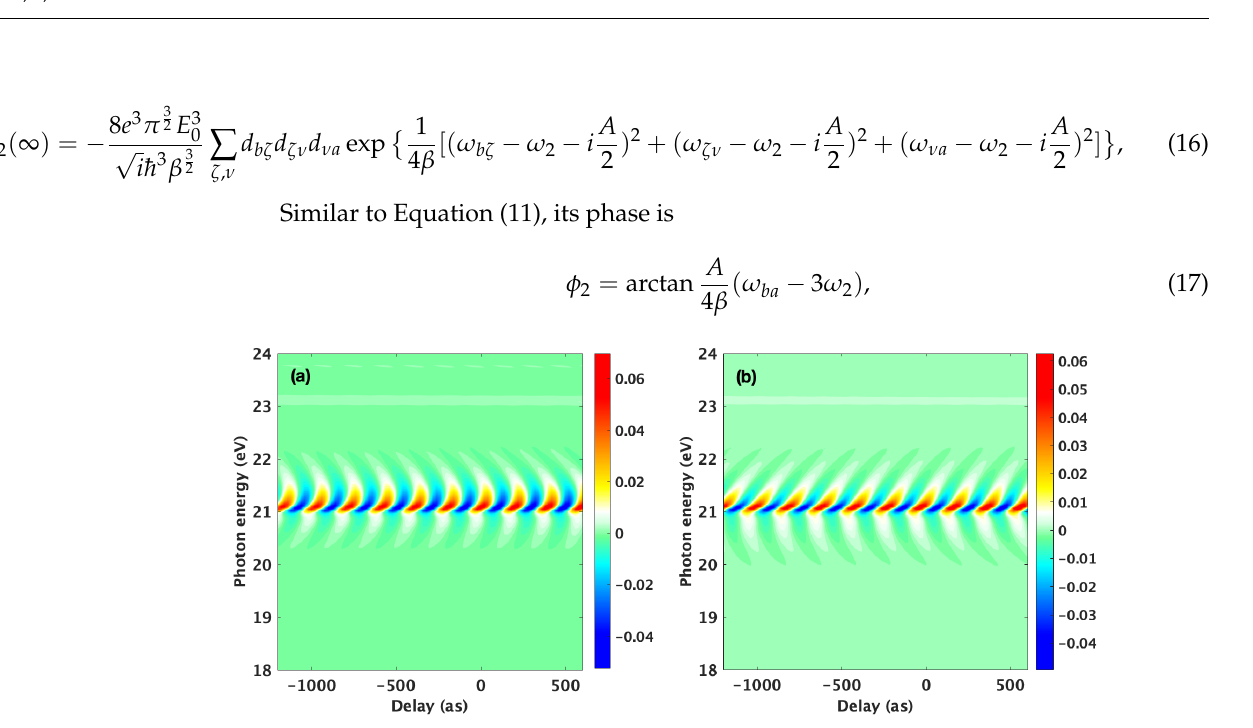
Figure 4. ATAS of a helium atom calculated using the 3D-TDSE for variable chirps: ( a ) ξ = − 4 and ( b ) ξ = +